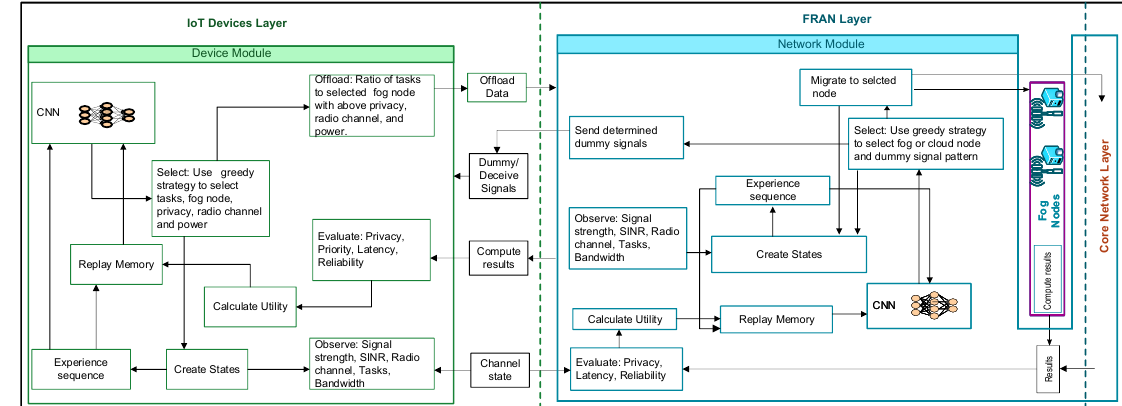
Figure 2. The functional architecture of Privacy Aware High Capacity Low-Latency Offloading (Device Module) and Defense against Attacks and Data migration (Network Module) components in